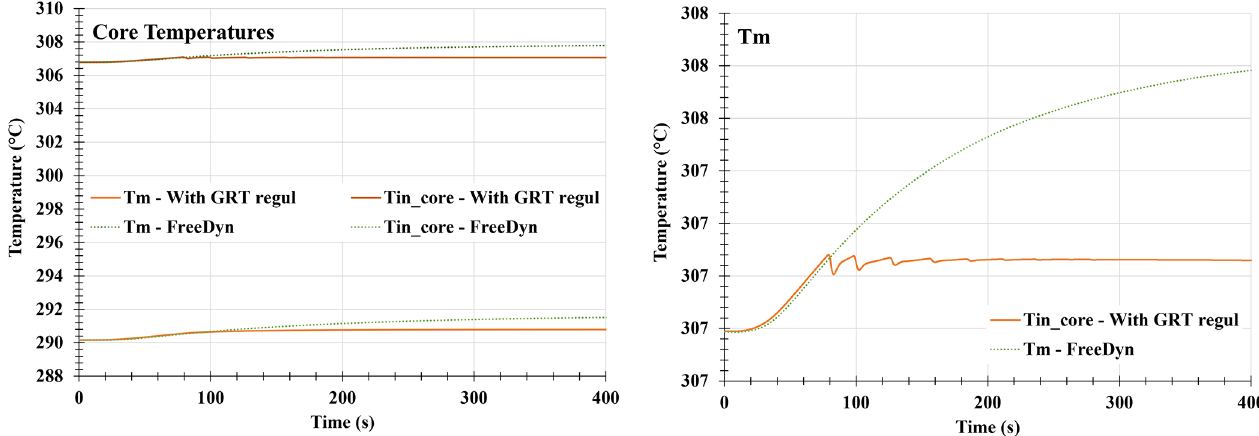
Fig. 2. Temperatures in the core including the average temperature in the core ( T m ) and inlet core temperature (Tin_core) during a primary frequency control transient.